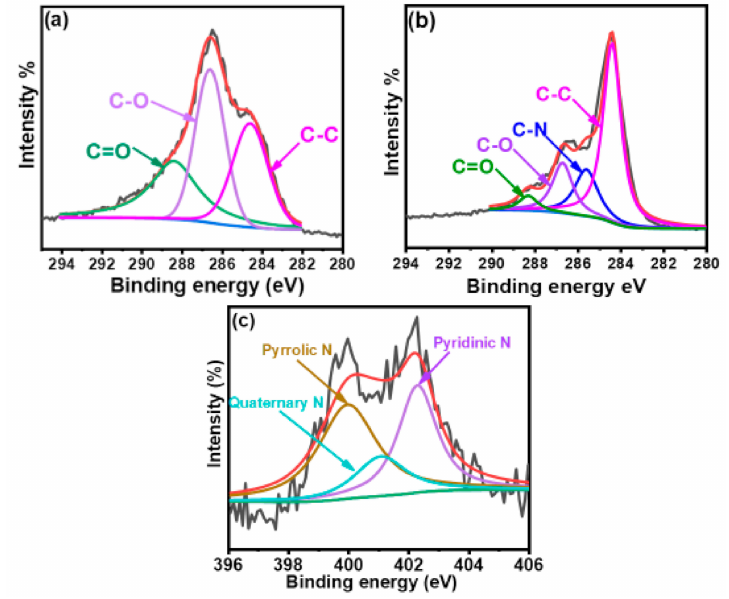
Figure 2. High resolution XPS spectra of C1s for; ( a )GO ( b ) HMTA-GO ( c ) N1s for